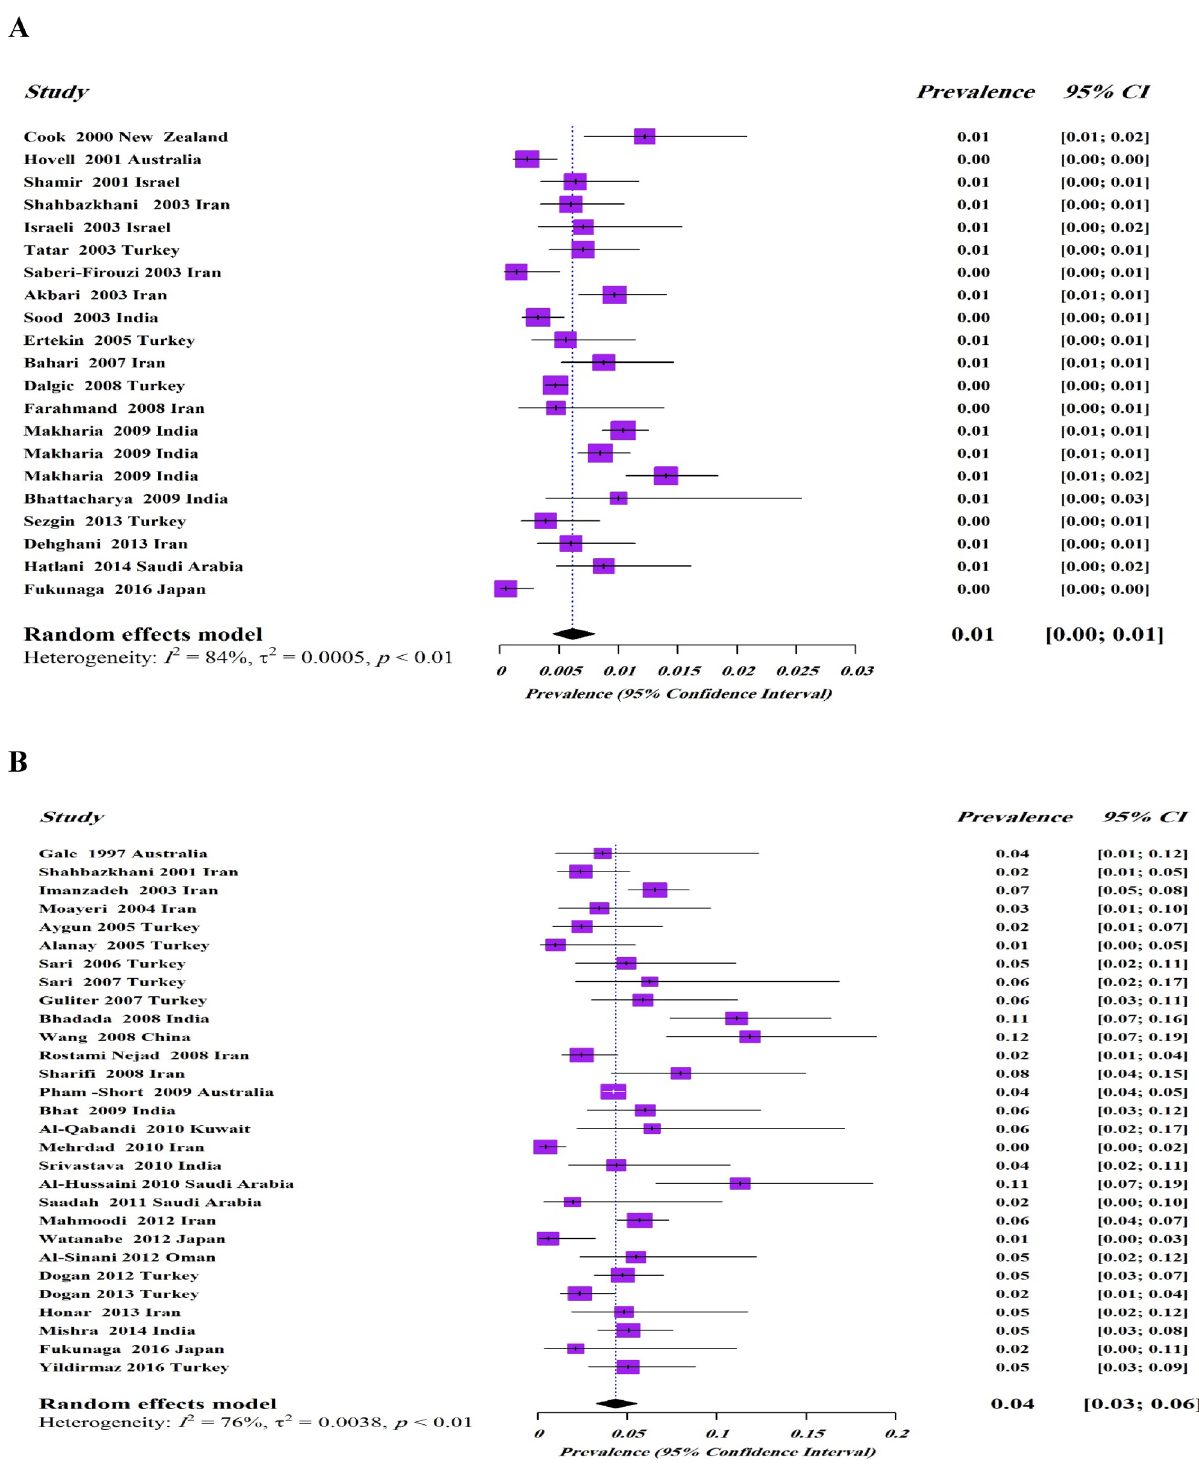
Figure 3. Forest plot for pooled prevalence of CD in Asia-Pacifioc region among ( A ) not at-risk population, ( B ) at-risk